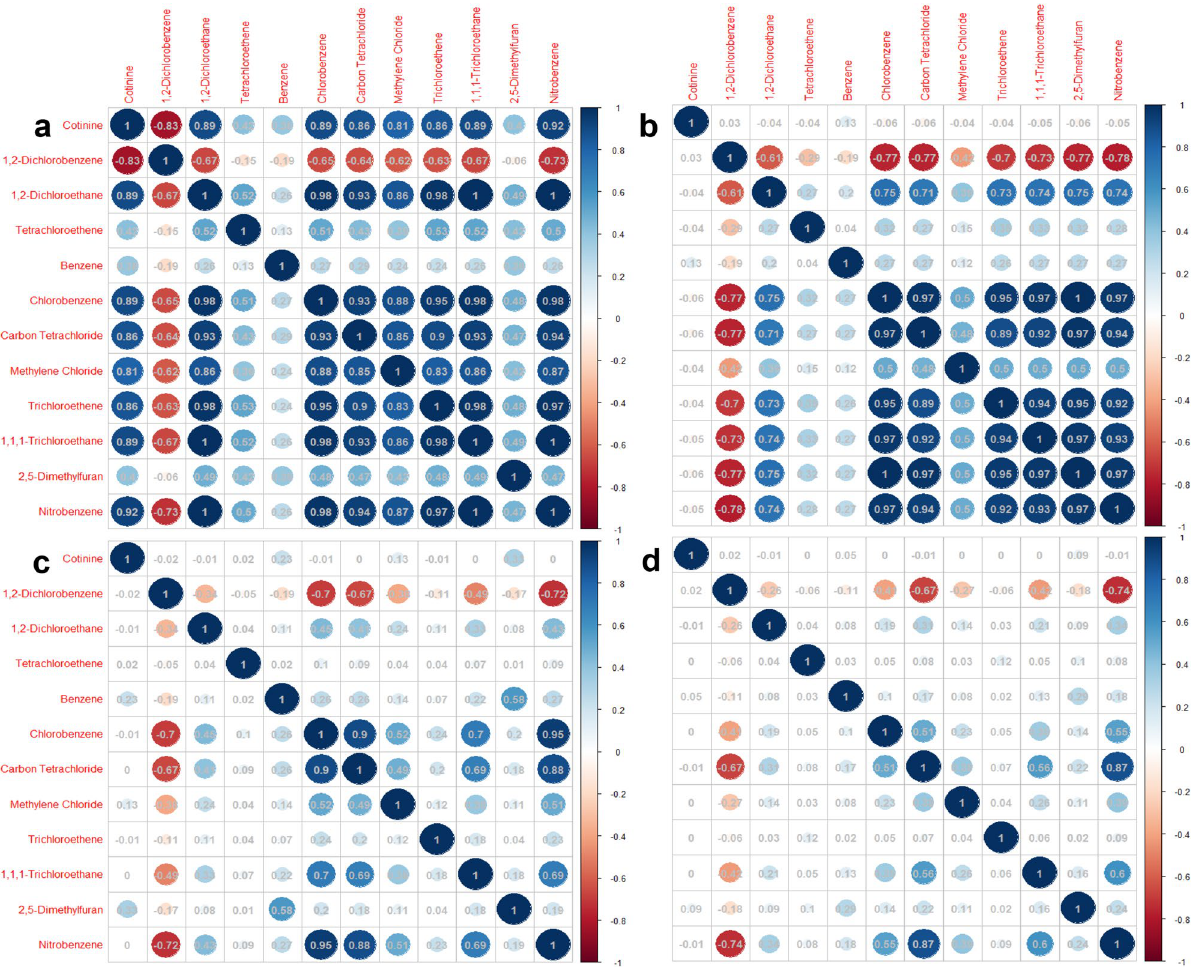
Figure 3. Spearman correlation analysis between serum VOCs and cotinine in different groups ( a. Smokers living with HIV, HBV, or HCV; b. Non-smokers living with HIV, HBV, or HCV; c. Smokers living without HIV, HBV, and HCV; d. Non-smokers living without HIV, HBV, and HCV).